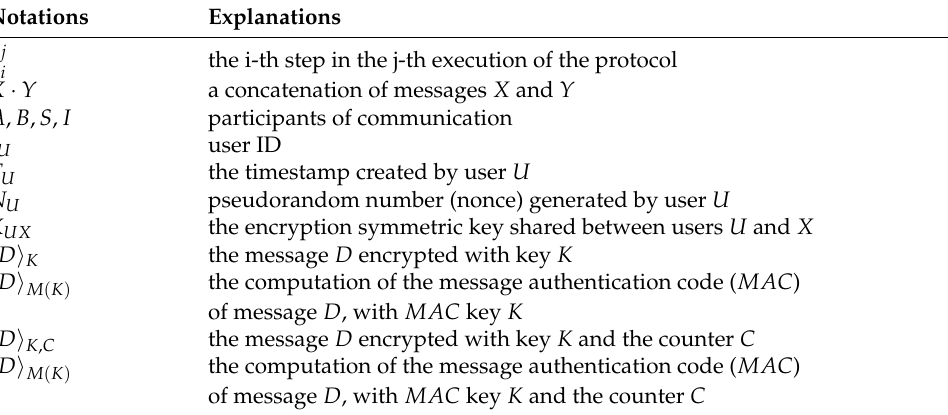
Table 1 presents the notations used in the article together with explanations: Table 1. Basic